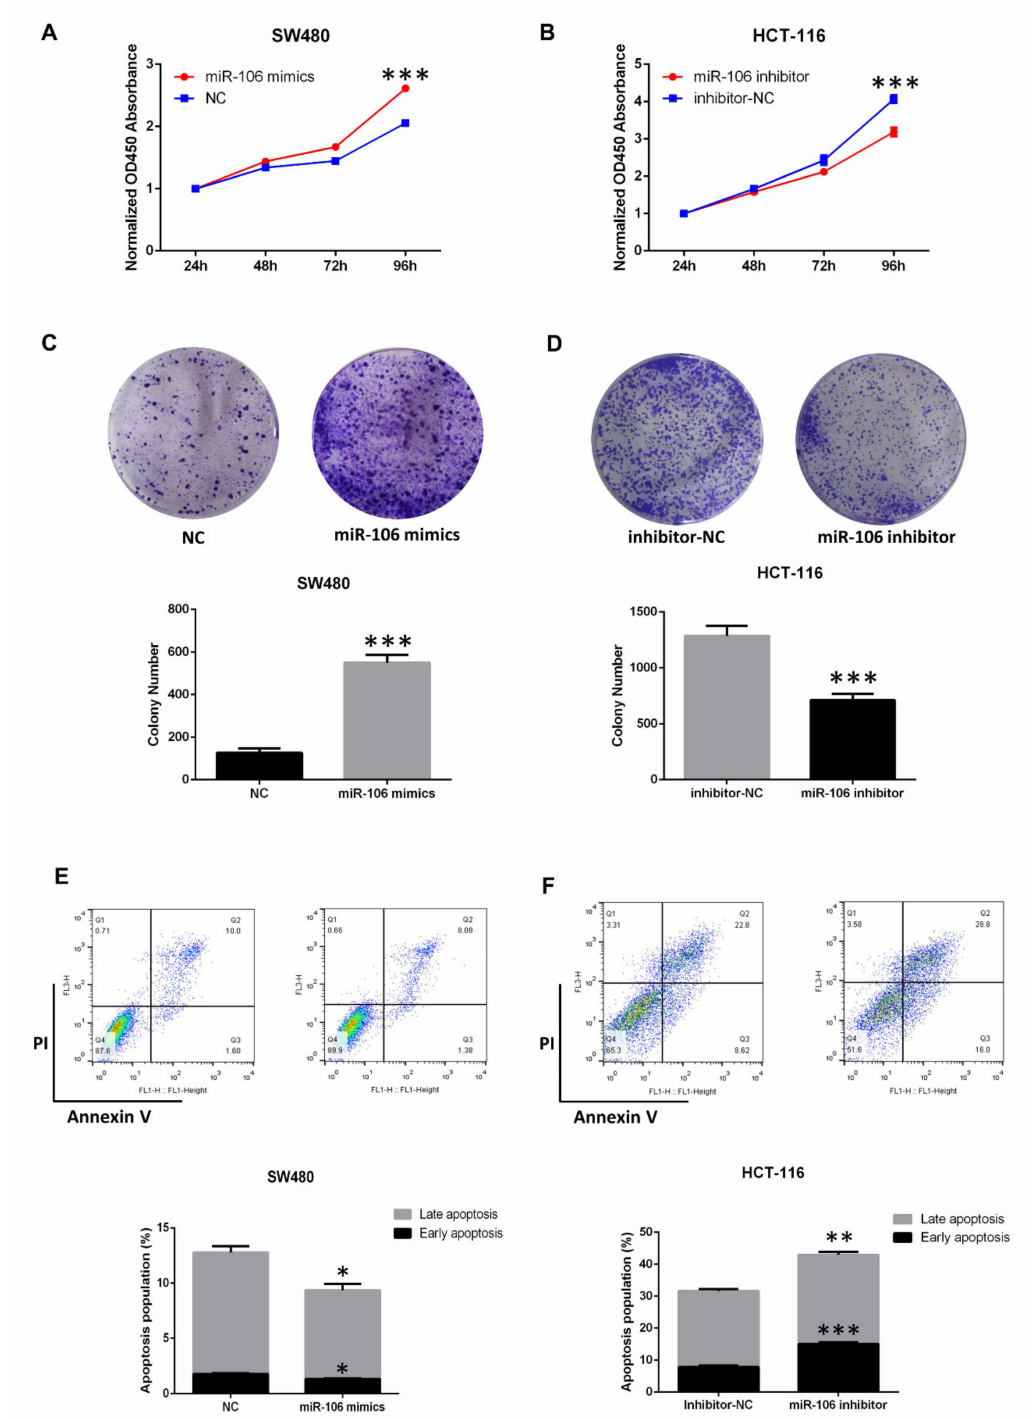
Figure 2. MiR-106b promotes CRC cell proliferation. ( A , B ) A CCK8 assay was used to assess the role of miR-106b mimics or inhibitor in CRC cell proliferation. ( C , D ) A colony formation assay was used to assess the role of miR-106b mimics or inhibitor in CRC cell proliferation. ( E ) The overexpression of miR-106b inhibits apoptosis in SW480 cells compared with the NC group. ( F ) The inhibition of miR-106b promotes apoptosis in HCT-116 cells. All data are shown as the mean ± SD ( n = 3), * p < 0.05, ** p < 0.01, *** p <